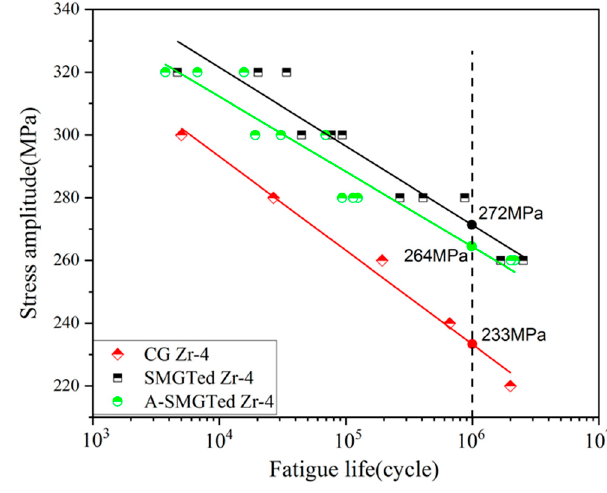
Figure 6. S-N curves of CG, SMGTed, and A-SMGTed Zr-4 samples. For the stress-controlled fatigue tests, the relationship between stress amplitude and fatigue life can be expressed by the Basquin equation: